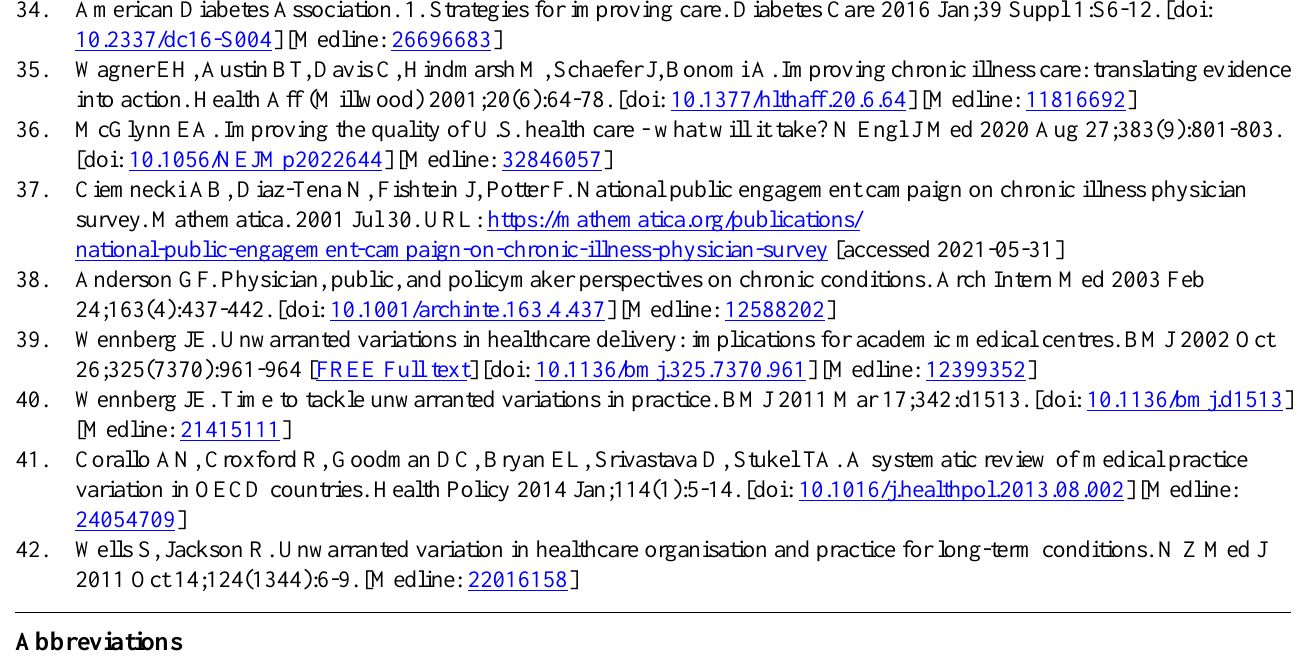
Abbreviations APP: advanced practice provider CGM: continuous glucose